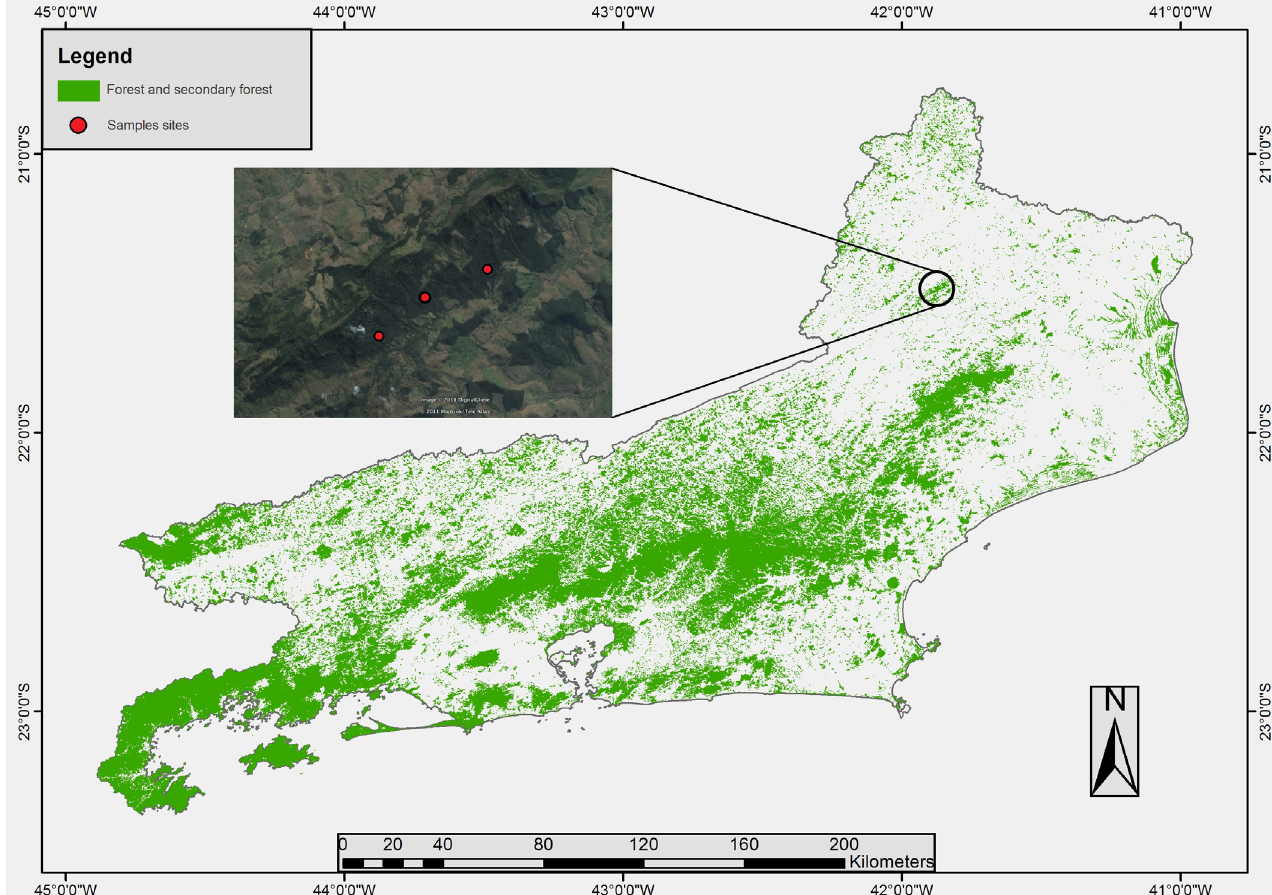
Figure 1. Map showing the location of the forest fragment analyzed in the municipality of Cambuci, state of Rio de